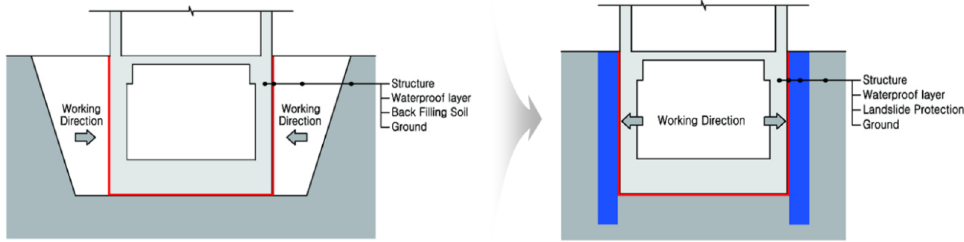
Figure 1. Conceptual diagram of single-side walls applied with existing waterproofing system technology.